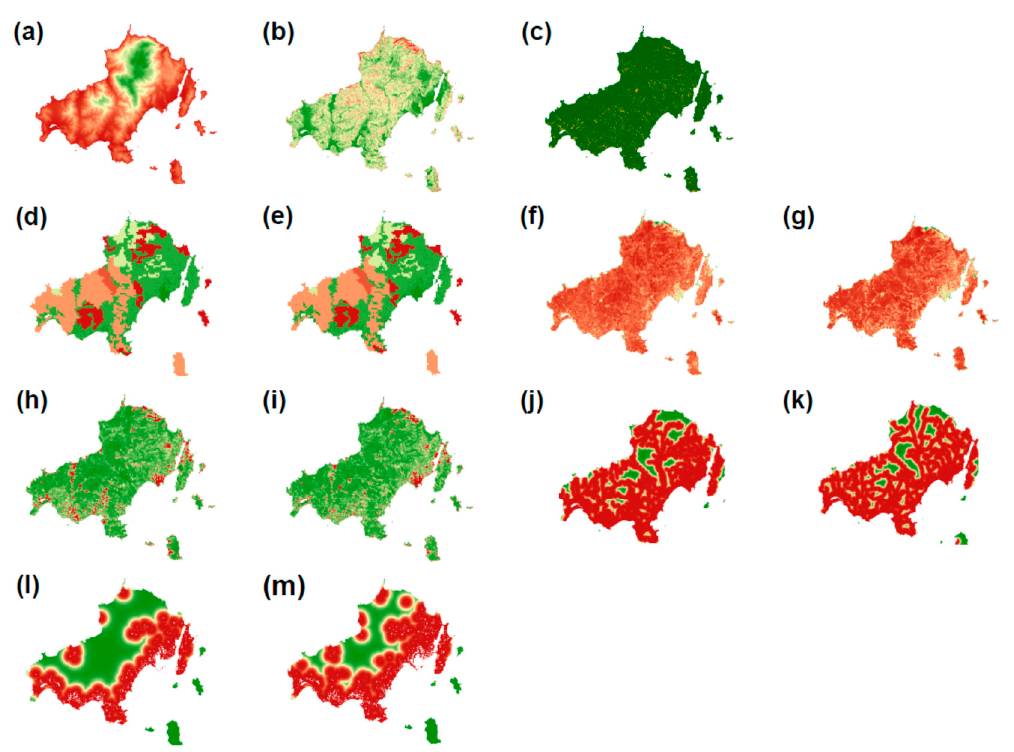
Figure A2. Fuzzy logic individual fire hazard maps for 1996 and 2016 (for all involved factors) ( a ) Elevation 1996–2016, ( b ) Slope 1996–2016, ( c ) Aspect 1996–2016, ( d ) Refined land cover 1996, ( e ) Refined land cover 2016, ( f ) NDVI 1996, ( g ) NDVI 2016, ( h ) NDMI 1996, ( i ) NDMI 2016, ( j ) proximity to road network 1996, ( k ) proximity to road network 2016, ( l ) proximity to human residences 1996, and ( m ) proximity to human residences 2016.